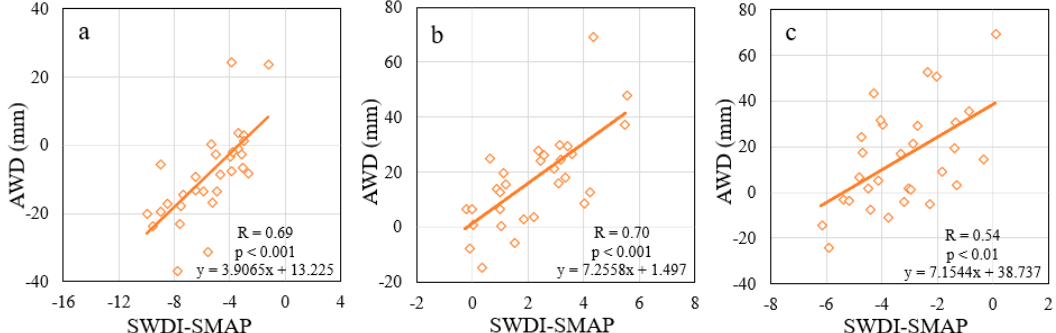
Figure 9. Comparison between the SWDI-SMAP and AWD over ( a ) region 1, ( b ) region 2, ( c ) region 3. 30 pairs of 7-day averaged data were used from 1 April 2016 to 30 September 2016.